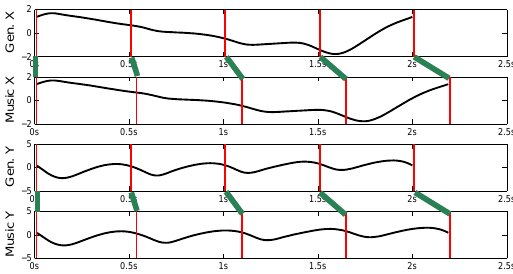
Figure 13. Making a beating-time gesture for music (Music X,Music Y) from a generalised trajectory (Gen X,Gen Y). The general trajectory is labeled Gen X for its X-coordinate and Gen Y for its Y coordinate, the synthesised gesture Music X and Music Y. All horizontal-axes express time in seconds. The procedure maps the goal points (metronomic ticks) of the generalised trajectory onto the goal points (beat points) of the music. The goal points are visualised by vertical red lines, the mapping by green lines. The synthesised beating-time gesture (Music X,Music Y) is calculated by linear temporal interpolation.